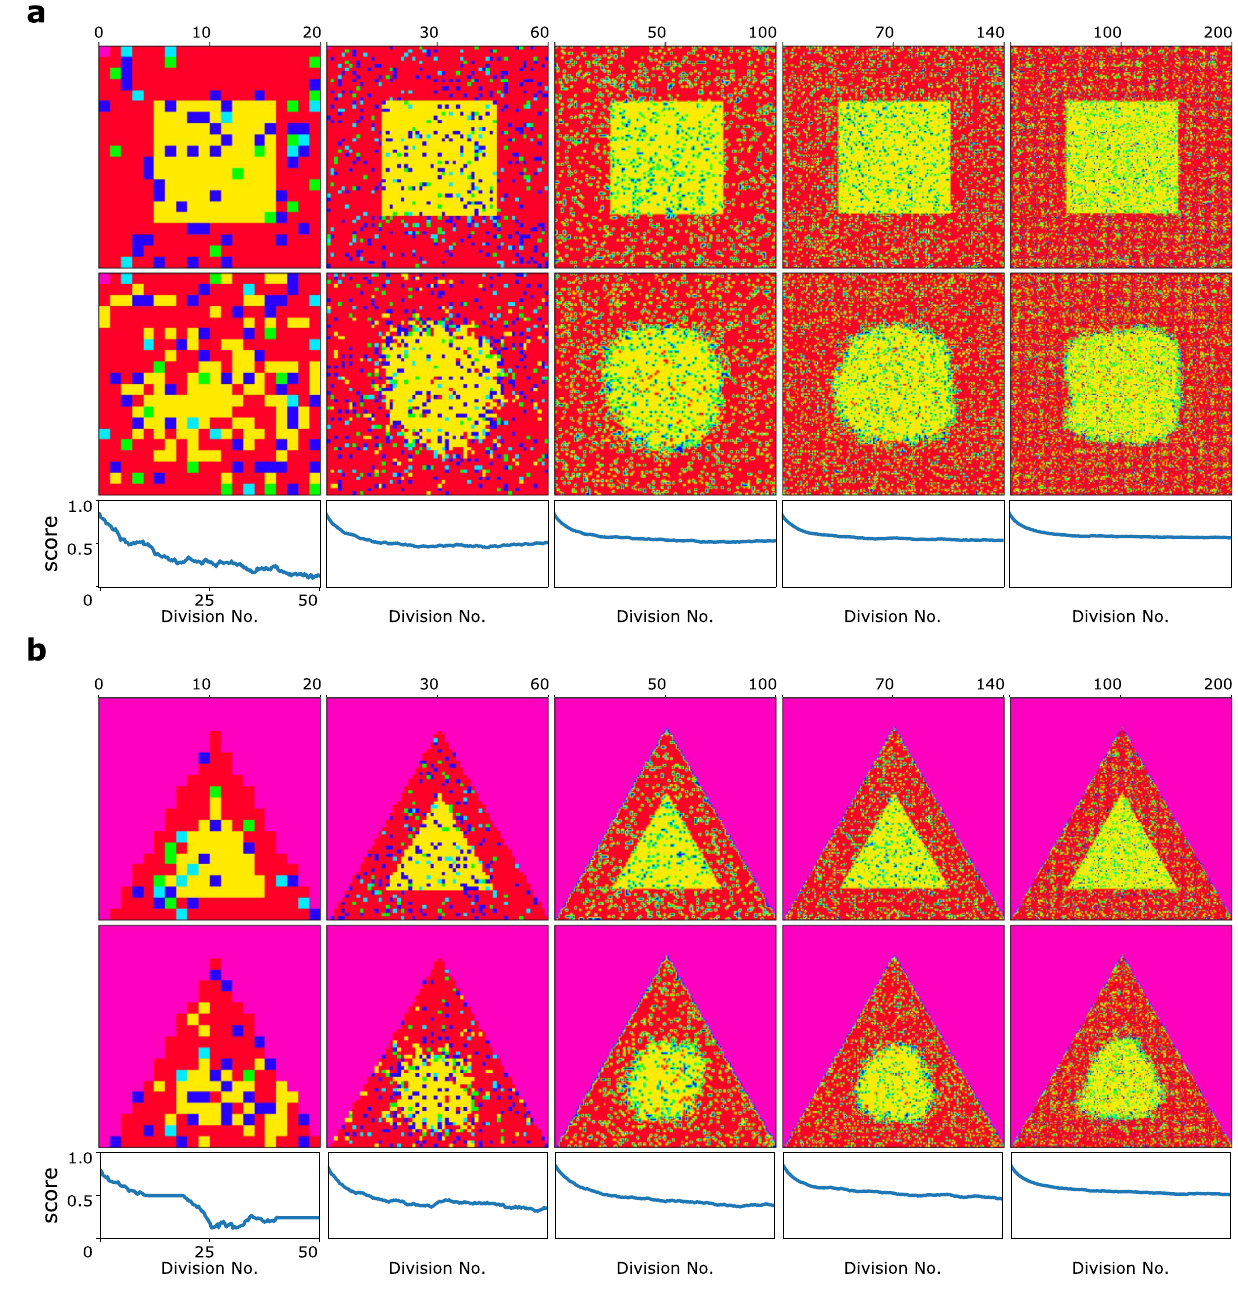
Figure 5. The system behaviour for rectangle shape, and triangle shape dishes. The length of the middle area is always the half of the dish side length. The first, and second rows represent the initial, an final states of the system, respectively. The corresponding score diagram of five mentioned simulations are shown in the last row. ( a ) Five different simulations starting with five rectangle shape dishes of side length, 10, 30, 50, 70, and 100 from left to right. ( b ) Five different simulations starting with five triangle shape dishes of side length, 10, 30, 50, 70, and 100 from left to